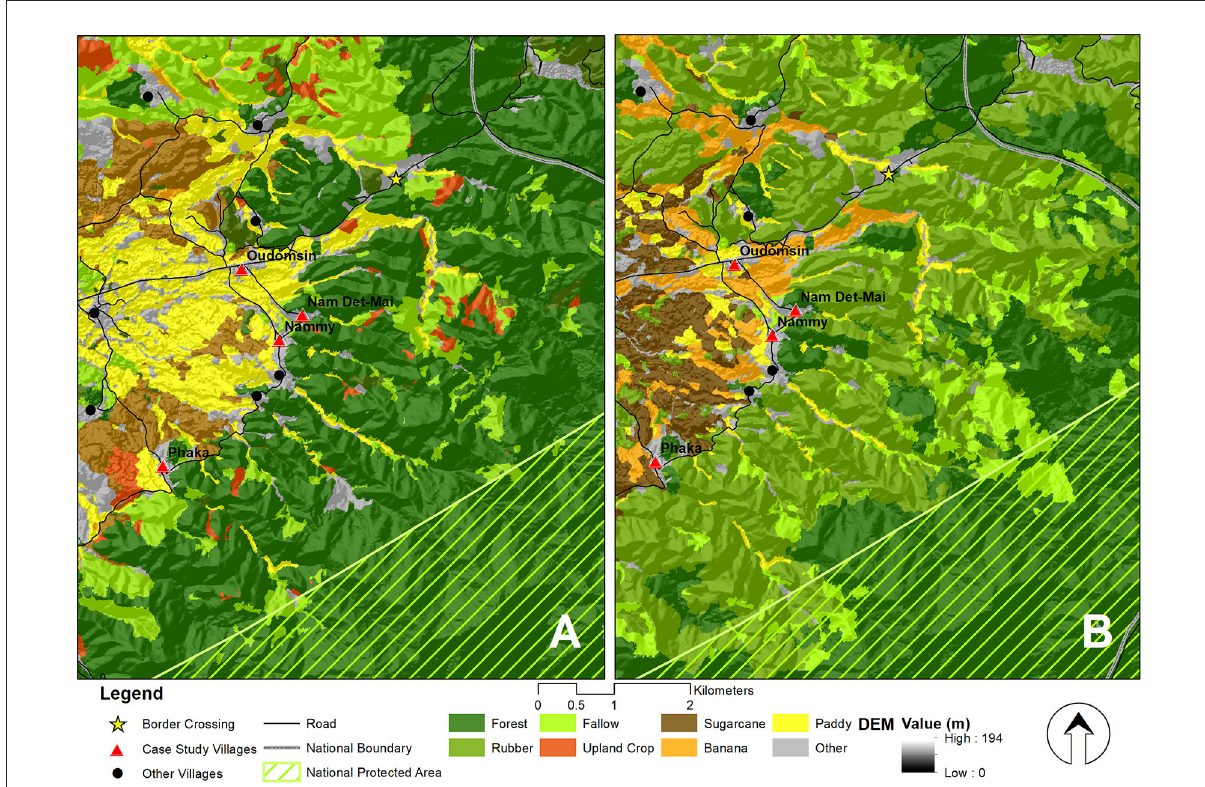
(Figure 2). At the same time, rubber plantations increased